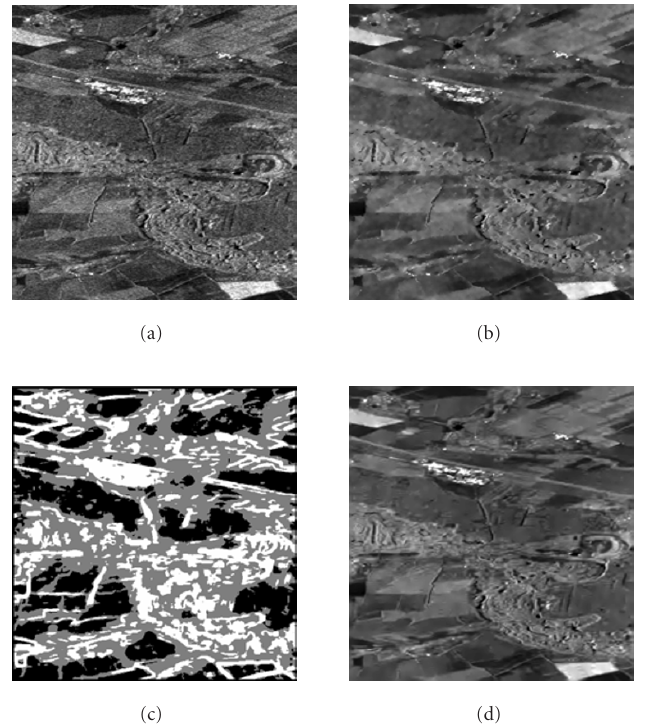
Figure 12: Visual example of SLAR image processing: (a) the original image, (b) the output of 7 × 7 MSF, (c) the PC map obtained by CPC2, and (d) the output of the proposed three-state